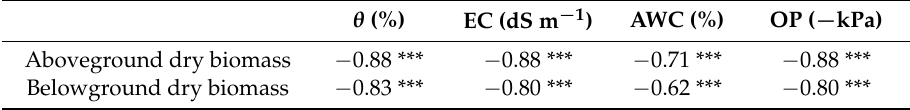
Table 2. Pearson correlation coefficients (R) between final maize biomass and mean θ (%), mean EC